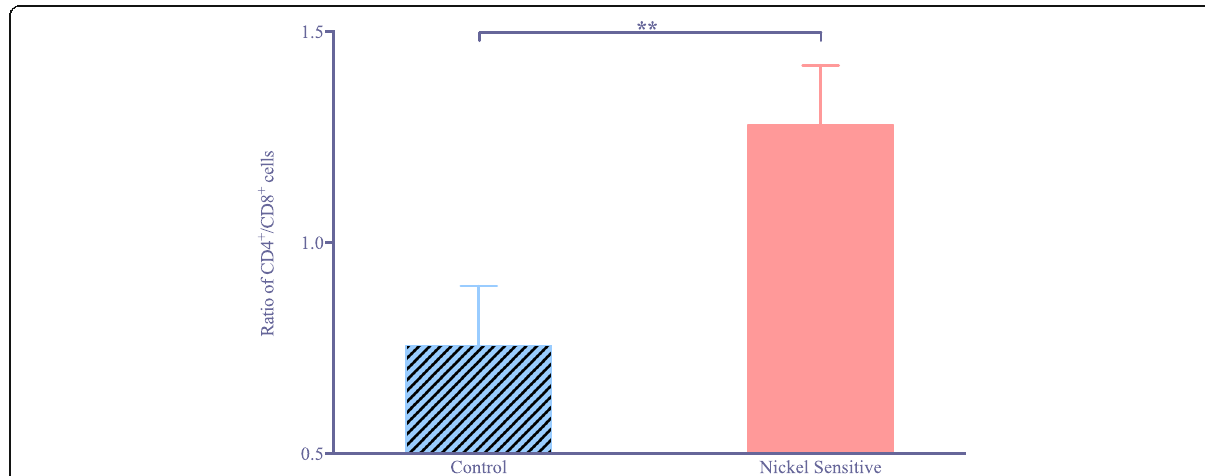
Fig. 2 Comparison of the ratio of CD4 + to CD8 + T cells between control ( n = 13) and nickel sensitive ( n = 19) groups. The control average is 0.76 and the nickel sensitive average is 1.28. Error bars show standard error. **Indicates p = 0.009